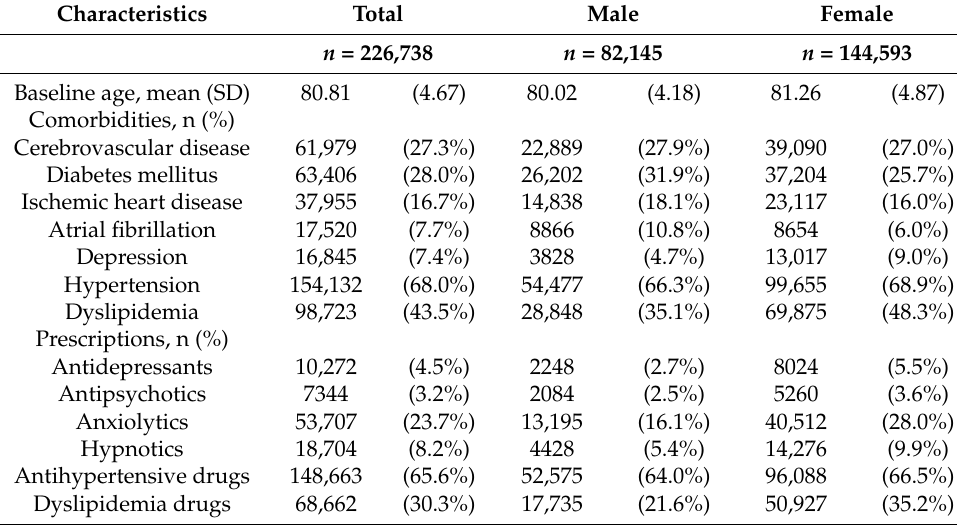
Table 1. Baseline characteristics of the study cohort by sex.